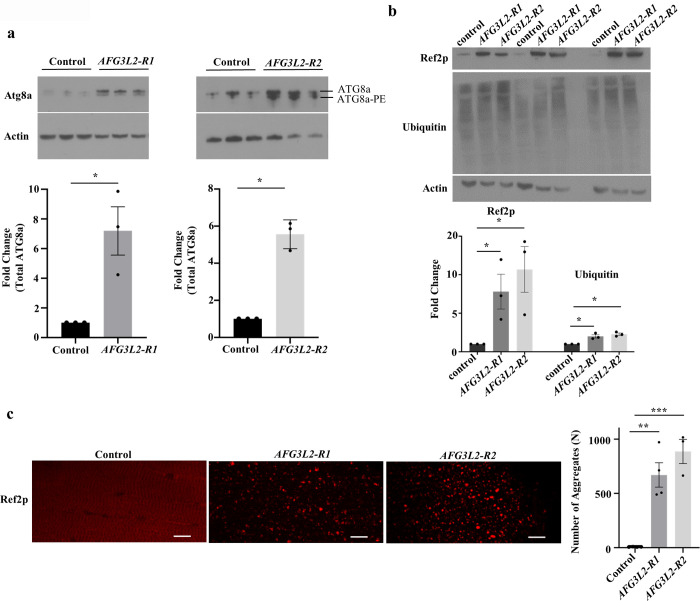
Macroautophagy is induced in AFG3L2-deficient animals.Western blot analysis of cell lysates from control (UAS-LUCIFERASE RNAi/da-Gal4) and AFG3L2-deficient (UAS-AFG3L2-R1 RNAi; da-Gal4 and UAS-AFG3L2-R2 RNAi/da-Gal4) pupae using antiserum to ATG8a (a), Ref(2)p (b) and ubiquitin (b). The lower of the two bands detected by the anti-ATG8a antiserum (designated ATG8a-PE) represents a phosphatidylethanolamine conjugated form of Atg8a, whereas the upper band represents the unconjugated form of the ATG8a. Antiserum against Actin was used as a loading control (N = 3 independent groups of 5 pupae, *p < 0.05 by one-way ANOVA Tukey's test for multiple comparison). c. Confocal images of indirect flight muscles from Control (UAS-LUCIFERASE RNAi/da-Gal4) and AFG3L2-deficient (UAS-AFG3L2-R1 RNAi; da-Gal4 and UAS-AFG3L2-R2 RNAi/da-Gal4) pupae using antisera against Ref(2)p. Scale bars are 5 μm. The right panel indicates the average number of Ref(2)p punctate (N = 4 for control and AFG3L2-R1 animals and N = 3 for AFG3L2-R2 animals, **p < 0.005 and ***p < 0.0005 by one-way ANOVA Tukey's test for multiple comparison).